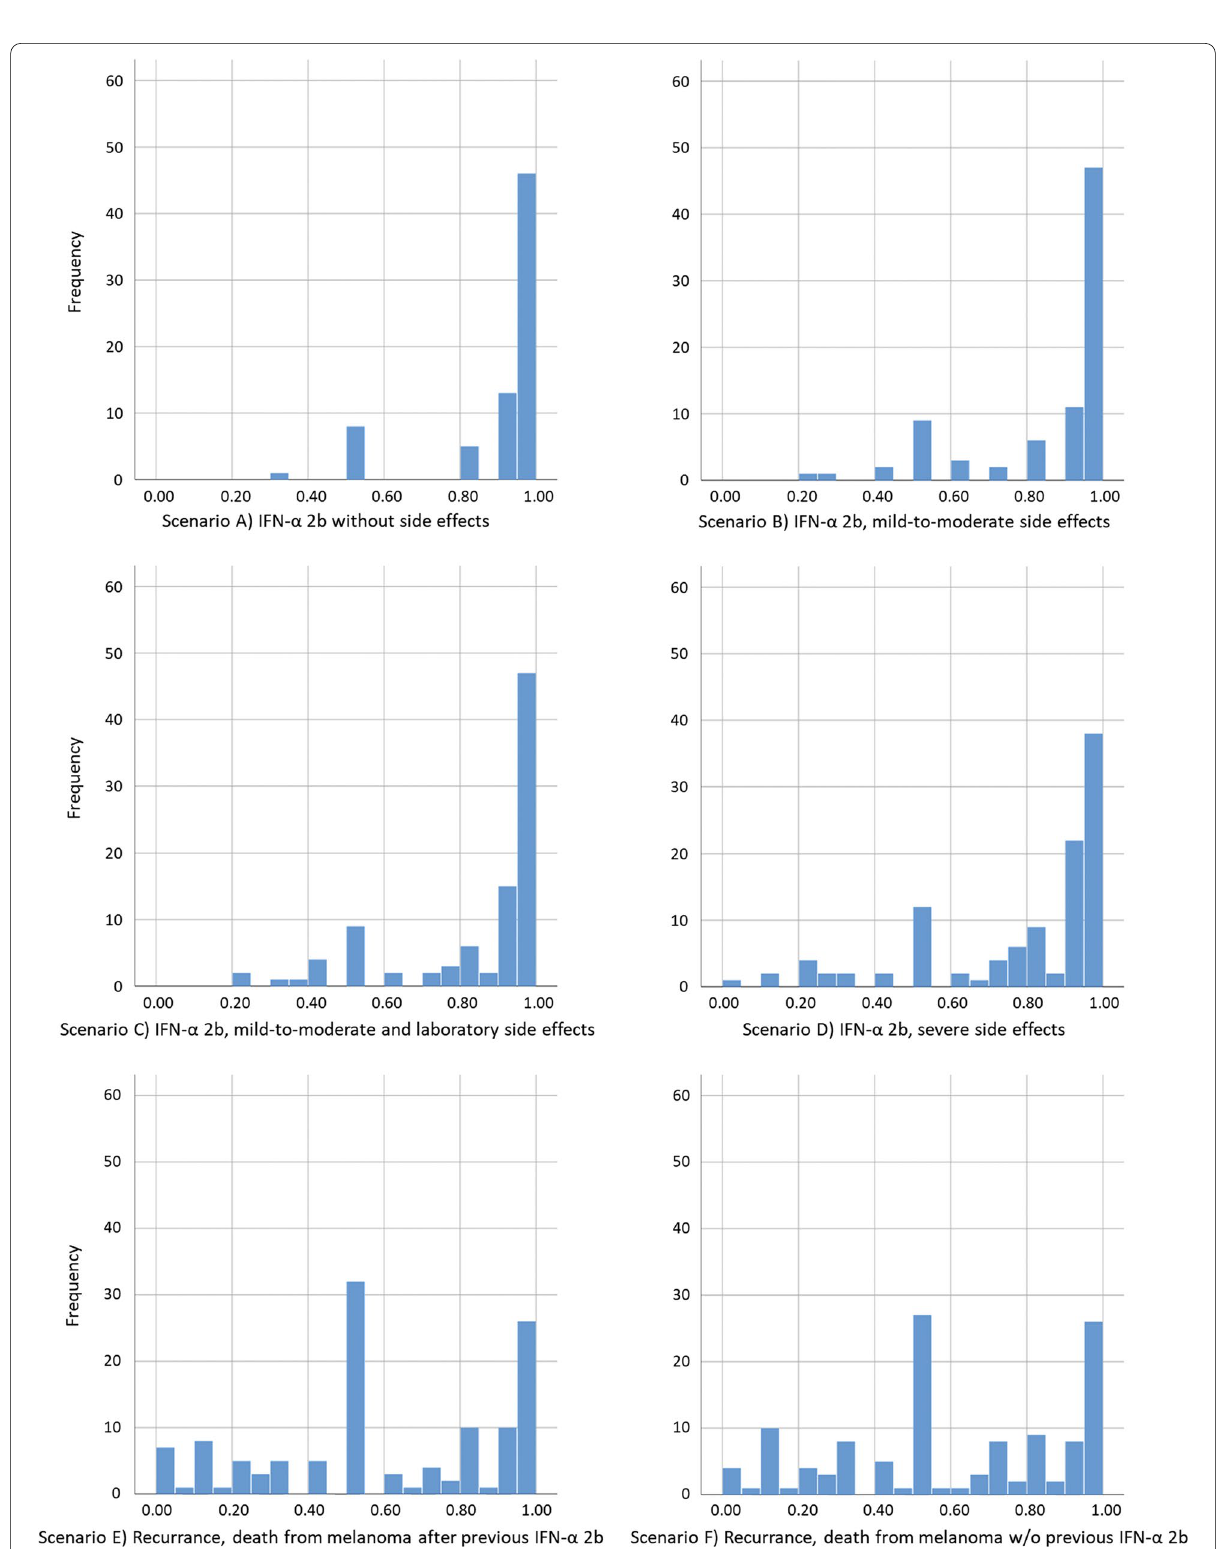
Fig. 2 Distribution of standard gamble utility ratings by